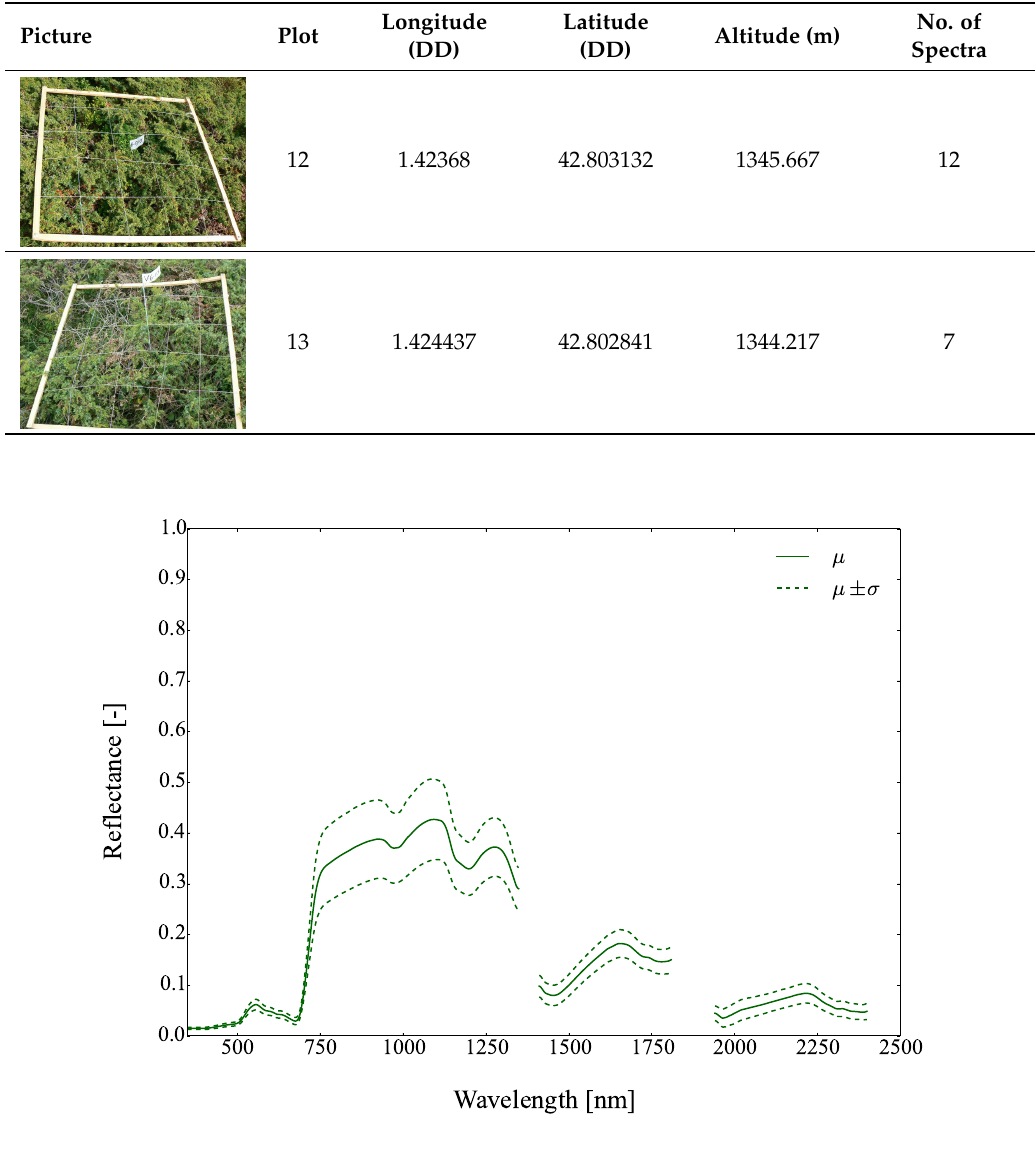
Figure A12. Mean reflectance ( µ ) and standard deviation ( σ ) of Juniperus communis